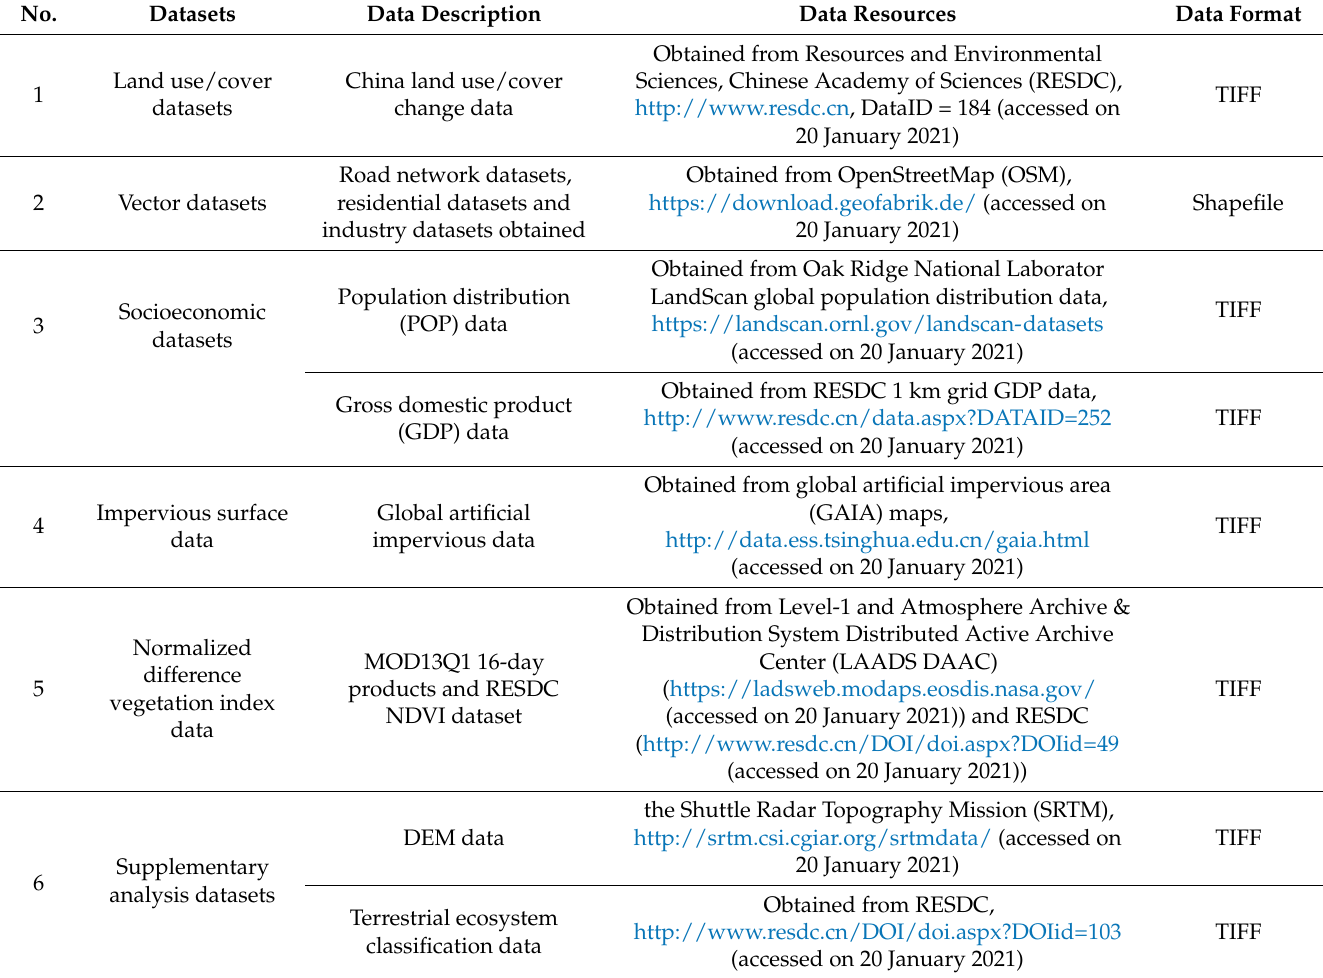
Table 1. Table 1. The datasets and resources used in this